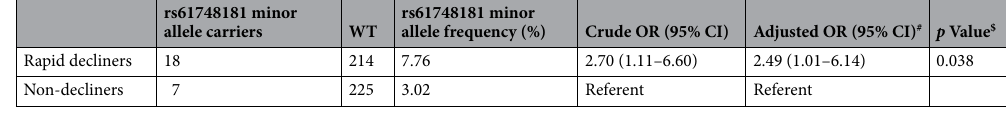
Table 3. The odds ratios of TERT SNPs rs61748181 among rapid versus non-decliners in the LHS. # The odds ratio adjusted for age and smoking history. $ p value fast versus non-decliners (CC versus CT + TT) for adjusted OR. Statistical analyses were done using the JMP Statistics software package version 13 (SAS Institute Inc.) and R version